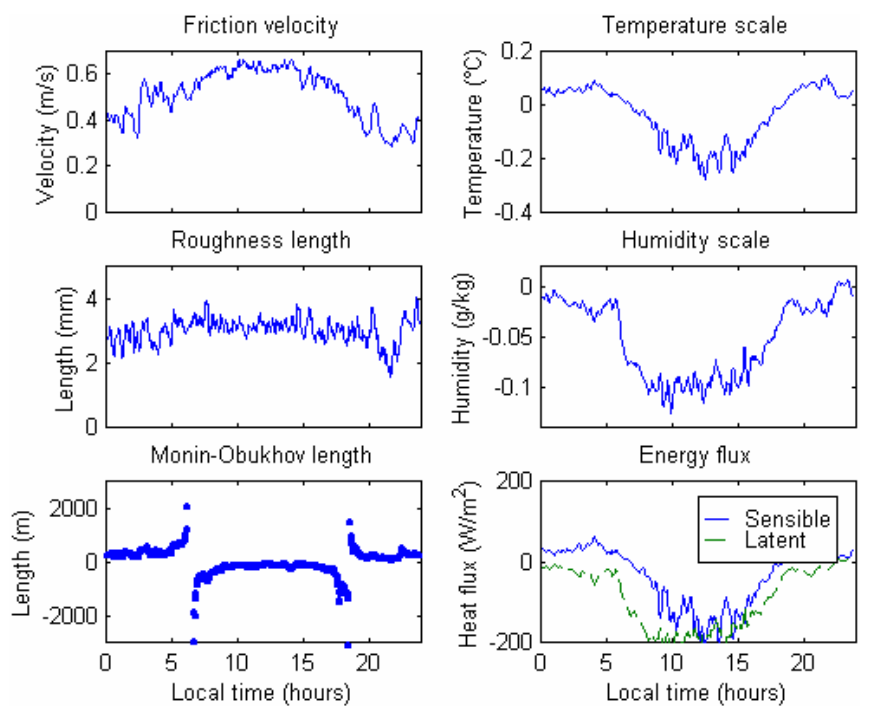
Figure 3: Dynamic parameters of that ASL (Plot CT, 25 July 1997) Fig. 3. Dynamic parameters of that ASL (Plot CT, 25 July